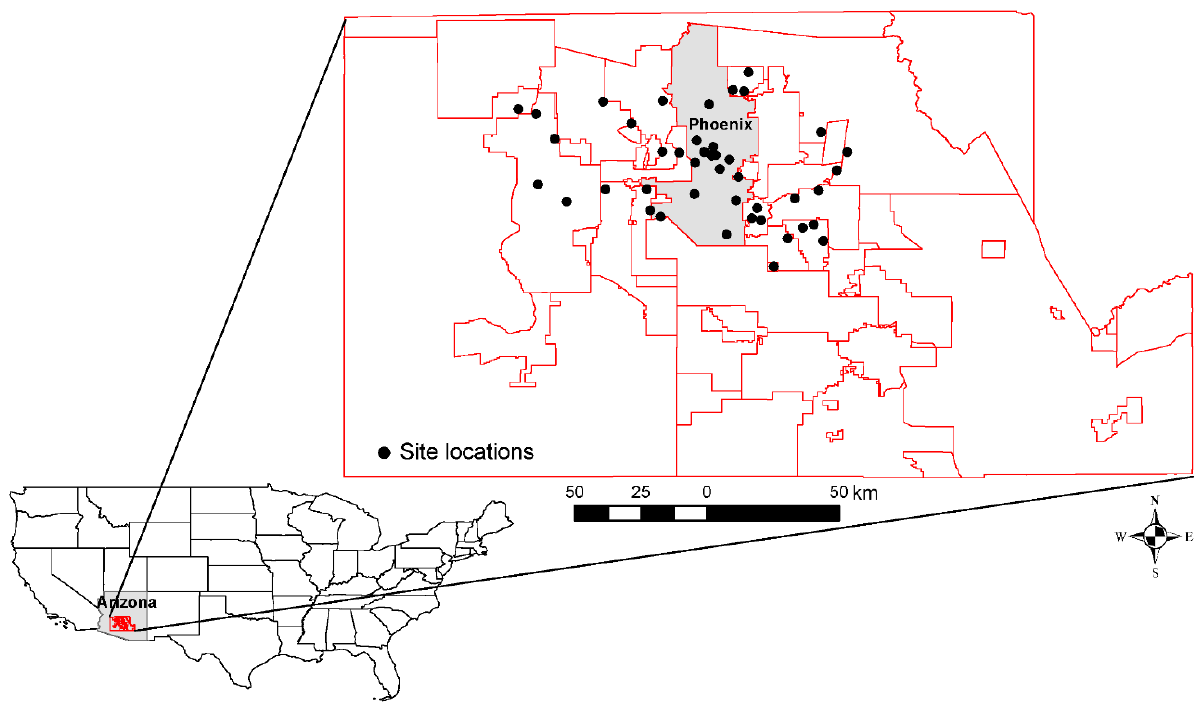
Figure 1. Geographical distribution of the sites used to estimate avian abundance and richness across the Phoenix metropolitan area. Red dots represent site locations. The delineations (in red) represent municipal planning areas (MPA). MPA data was extracted from AZGeo Data—Municipal Planning Areas